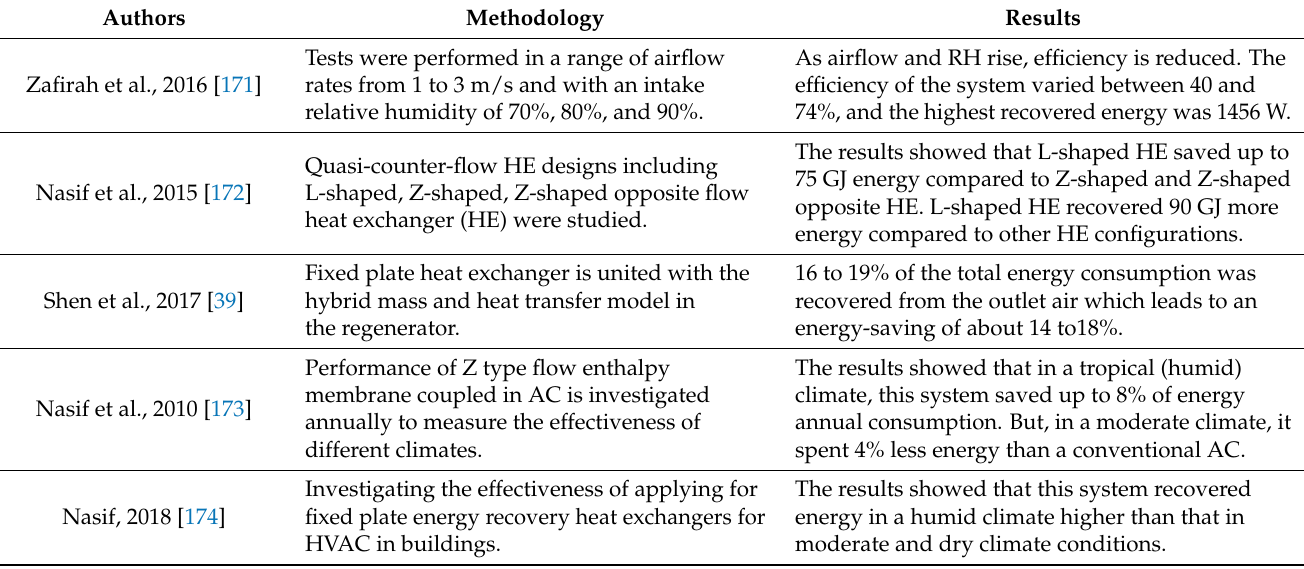
Table 9. Summary of the investigated papers related to the fixed plate effect on HVAC